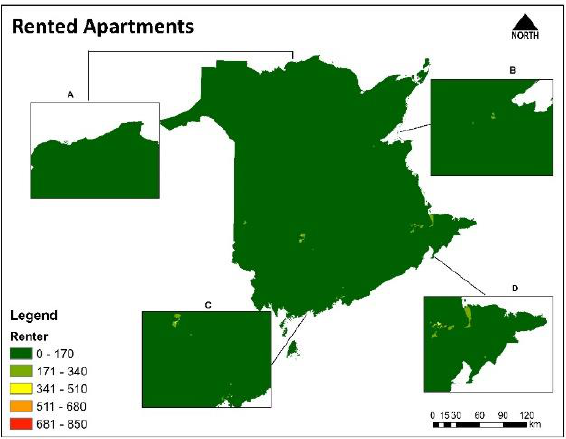
Figure A14. Population Density (km 2 ).